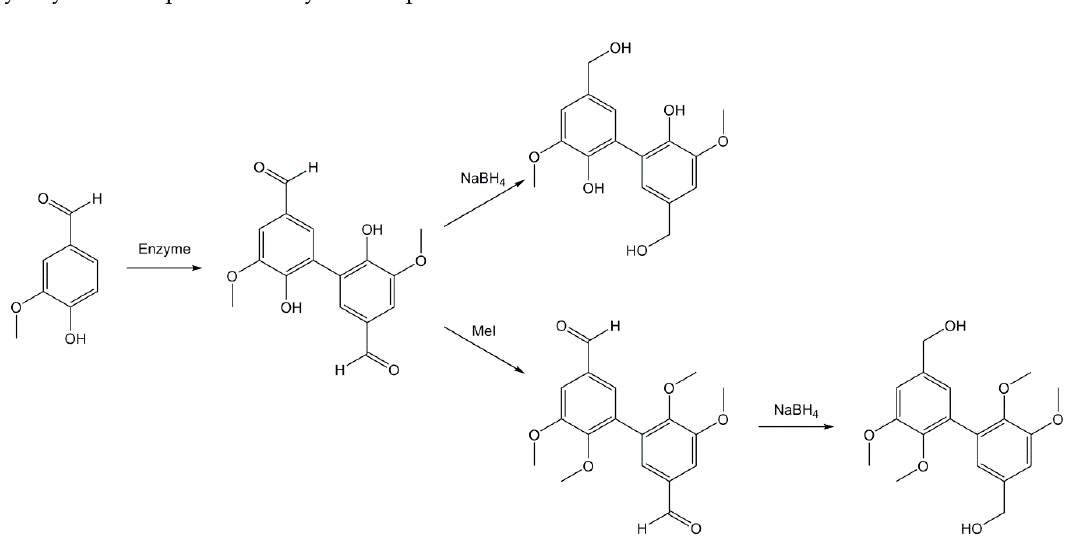
Figure 19. Bio-based di-aromatic epoxy derivatives with a single carbon atom spacer. Harvey et al. [117] synthesized di-epoxides ( 27 ) through methylene bridging between two carvacrol molecules with 1,3,5-trioxane in dilute HCl at elevated temperature (Figure 19) and O -glycidylation using epichlorohydrin, with an overall yield of 42%. The resulting monomer was cured with 4,4 ′ -diaminodiphenyl methane and 4,4 ′ -methylene bis(5-isopropyl-2-methylaniline), also prepared from